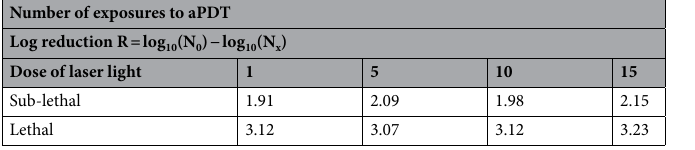
Table 1. The effect of multiple photosensitization on the reduction in the number of A. baumannii cells. N 0 is the number of viable cells before treatment; N x is the number of viable cells after treatment.